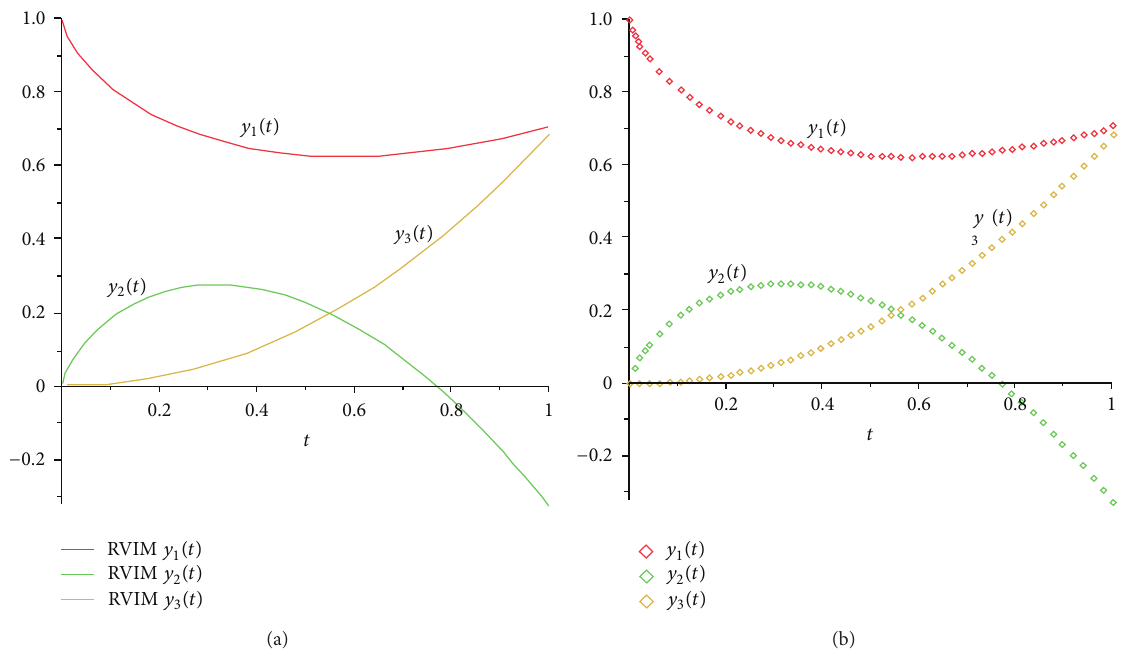
Figure 3: Plots of system (23): (a) RVIM method and (b) differential transform